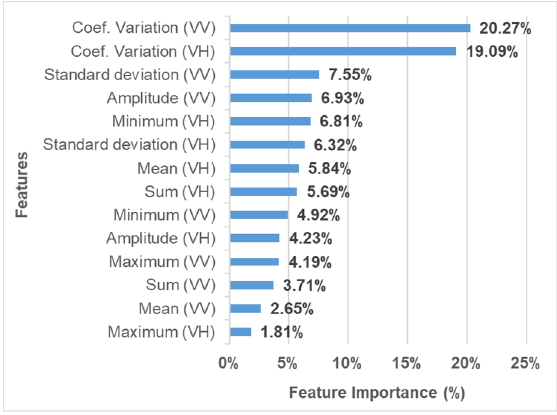
Table 1. Confusion matrix regarding the RF classification performed using metrics extracted from the combined VV and VH TS (in pixels)